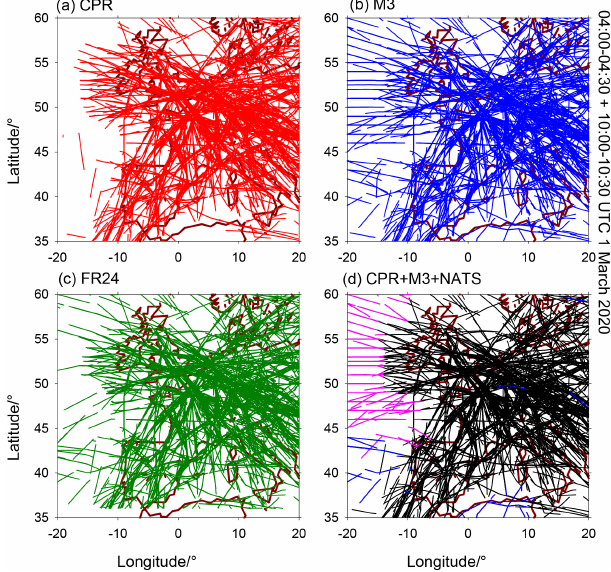
Figure 1. Geographic map of the European domain under consider- ation for contrail simulations with colored flight tracks for two half- hour example time periods on 1 March 2020, before the COVID-19 crisis. Individual panels show track data from (a) CPR (red), (b) M3 (blue), (c) FR24 (green), and (d) the combination of CPR with M3 and NATS data for flights extending beyond the CPR range (black, blue, and purple